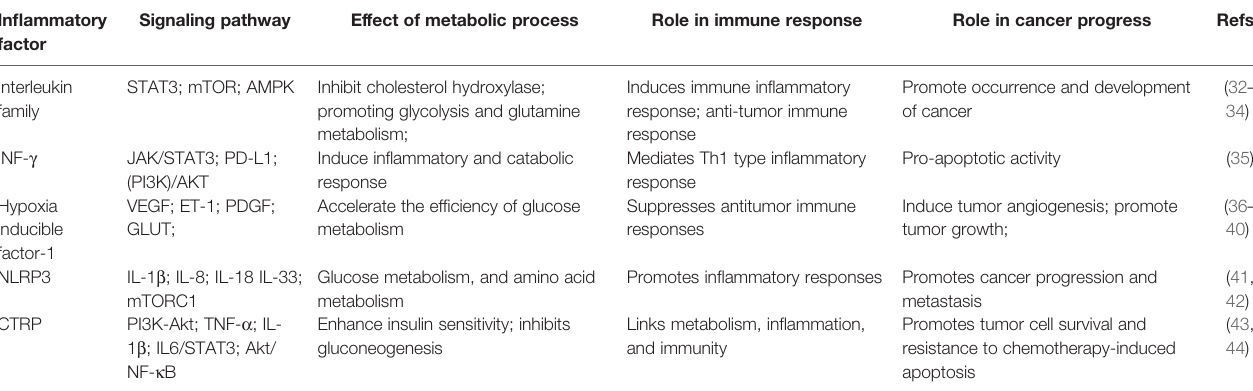
TABLE 1 | In fl ammatory factor that regulating the metabolic remodeling and cancer microenvironment. In fl ammatory